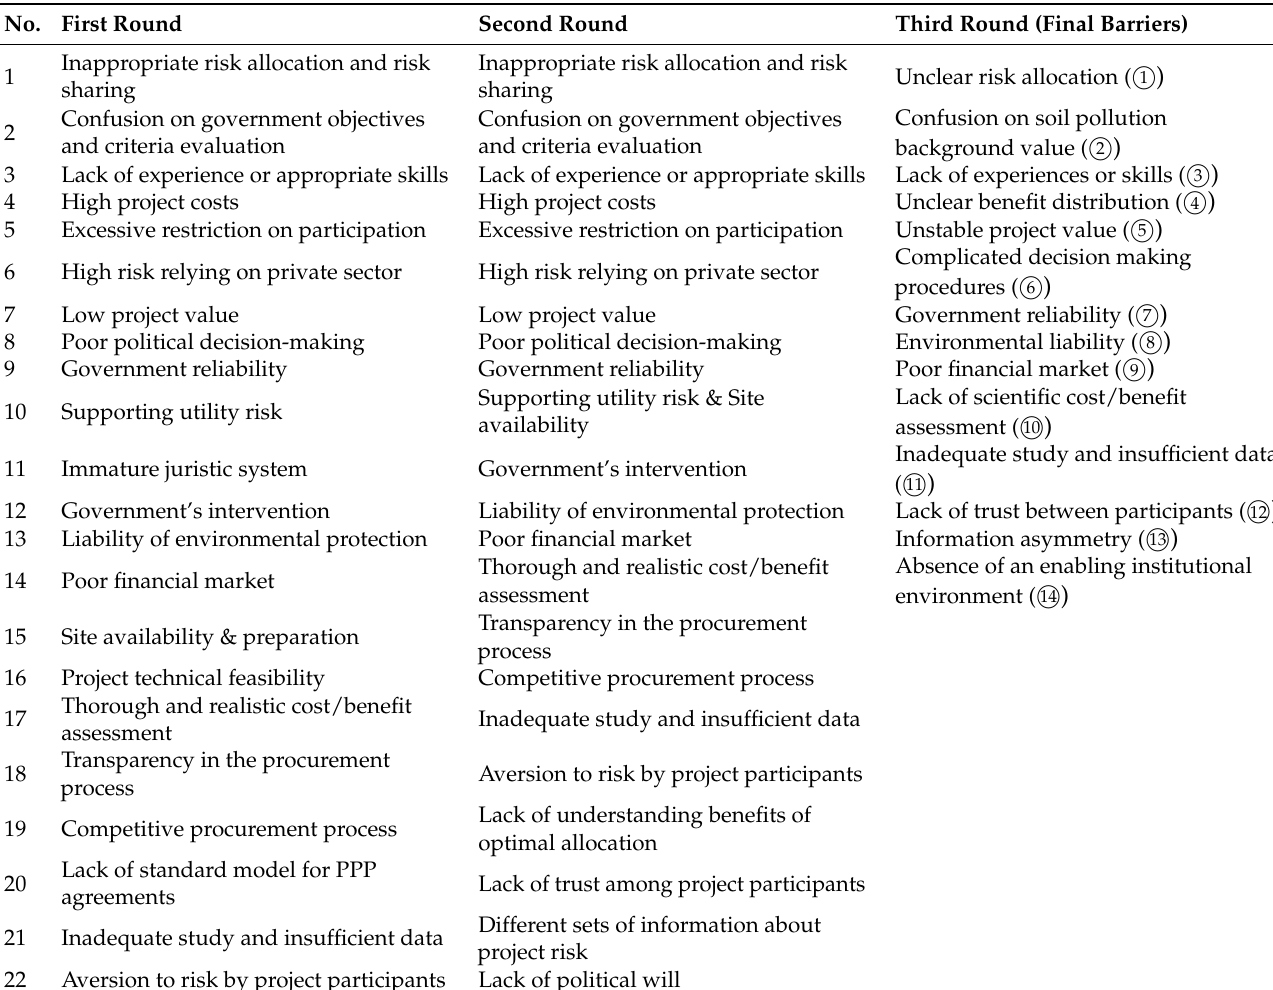
Table 2. Final barriers of PPP brownfield remediation projects in